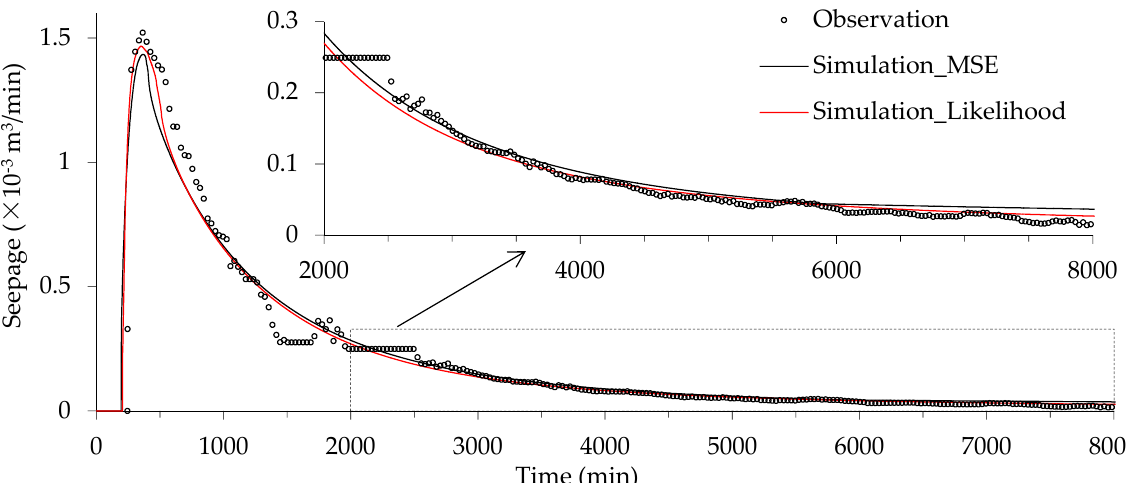
Figure 8. Comparison between observed and simulated soil tank seepages in the third rainfall–runoff experiment for model validation.